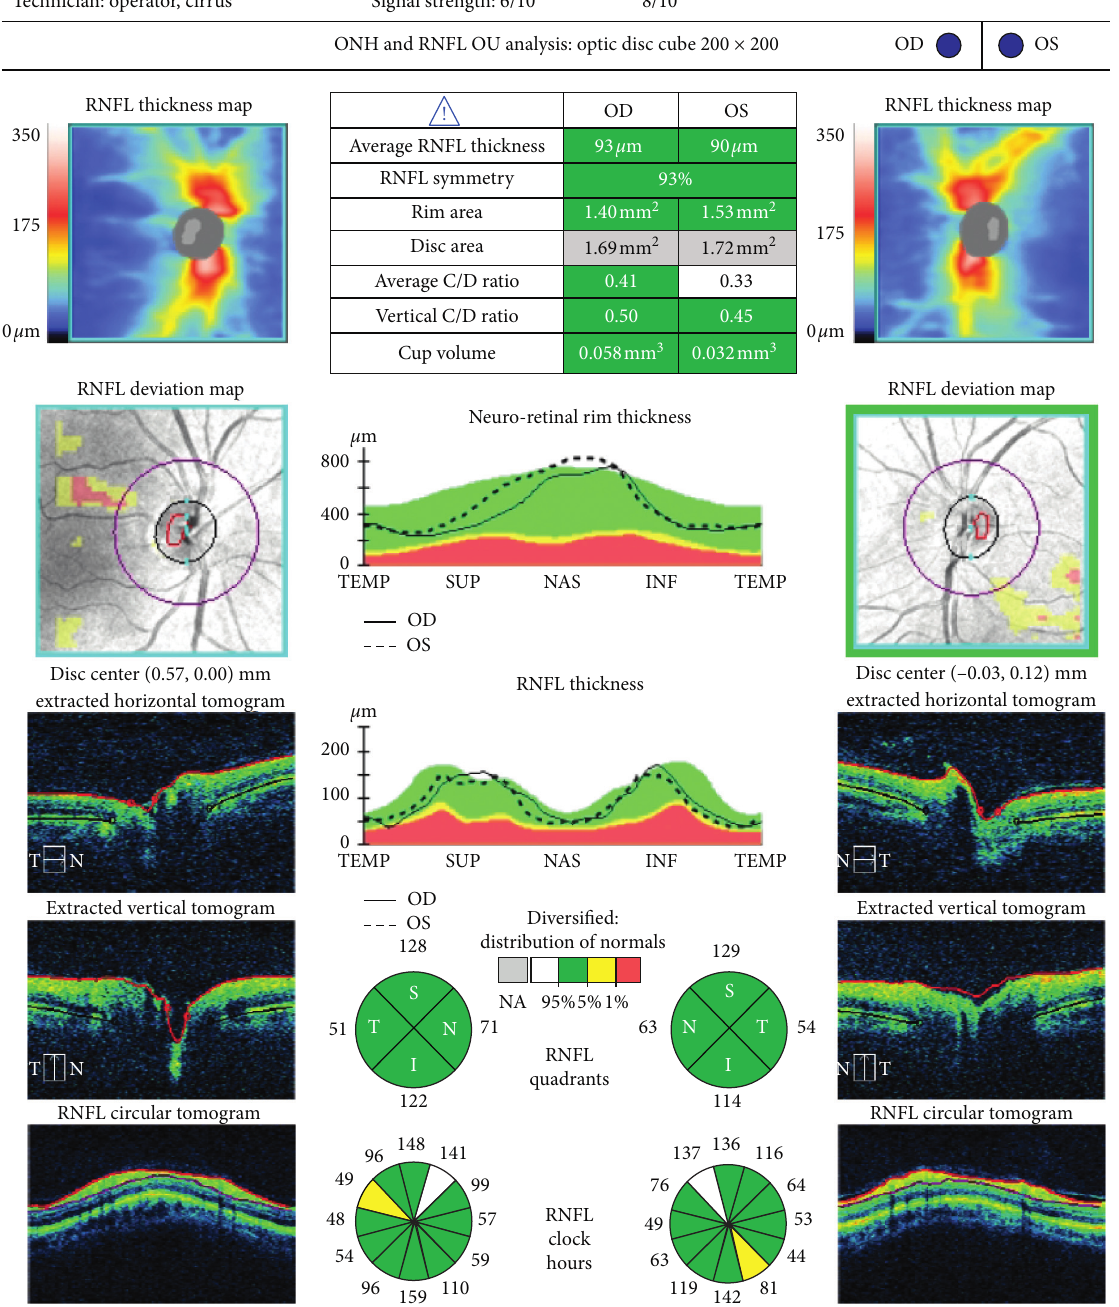
Figure 3: Preoperative retinal nerve fiber layer (RNFL) analysis of a 74 year-old